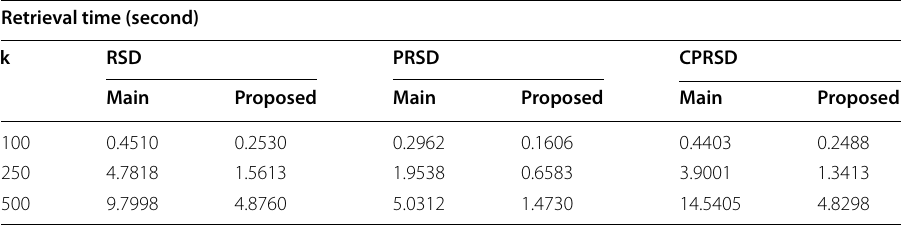
Table 2 Retrieval time comparison between main and proposed decoding process Retrieval time (second)